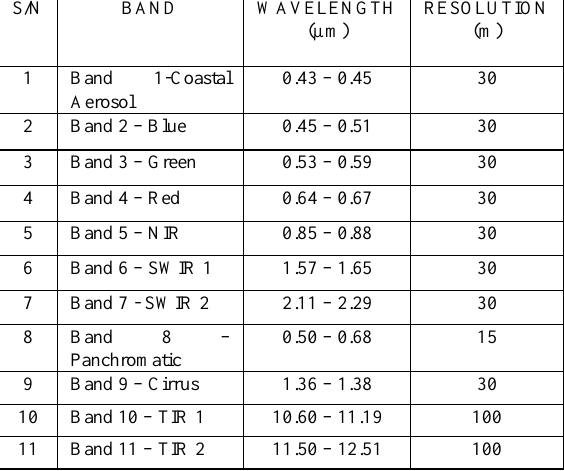
Table 1: Spectral characteristics of Landsat-8 image data.